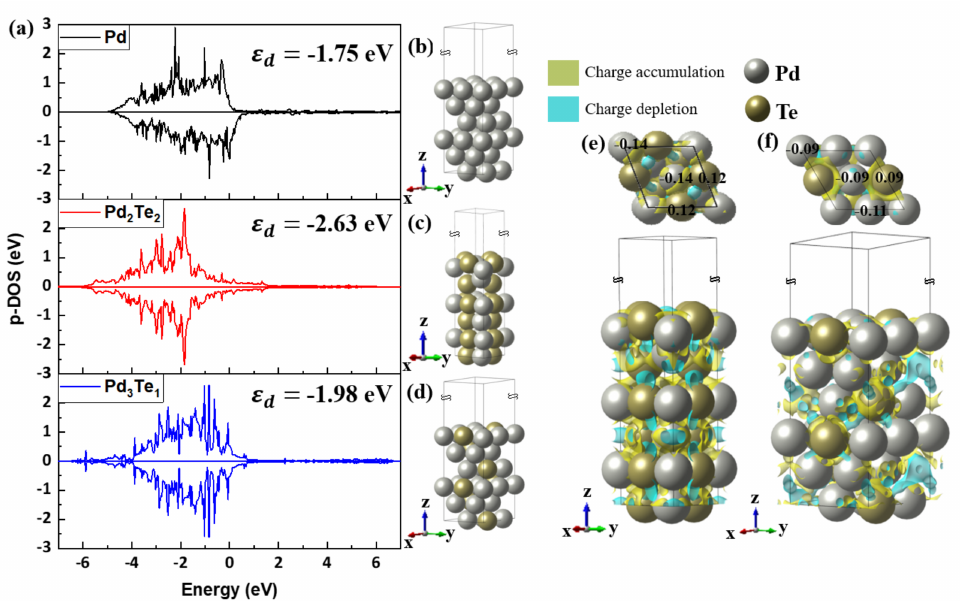
Figure 7. ( a ) Projected d-DOS spectral profiles recorded for the Pd atom. Data for the surfaces of ( b ) Pd (111), ( c ) Pd 2 Te 2 (111), and ( d ) Pd 3 Te 1 (111). Bader charge analysis and charge difference recorded for ( e ) Pd 2 Te 2 and ( f ) Pd 3 Te 1 slab models. The yellow and blue colors denote negative charge accumulation and depletion,